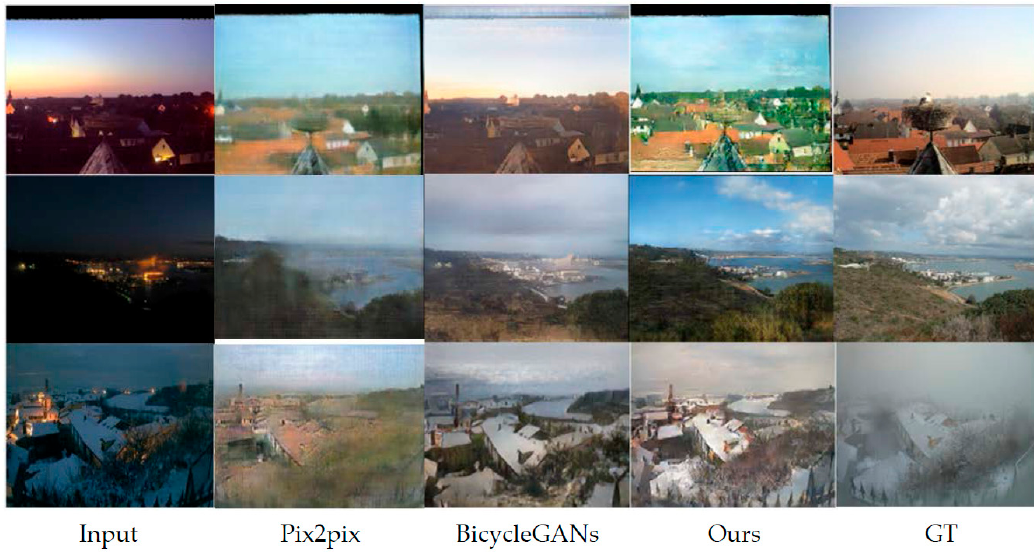
Figure 5. Comparison of night → day with pix2pix, BicycleGANs.